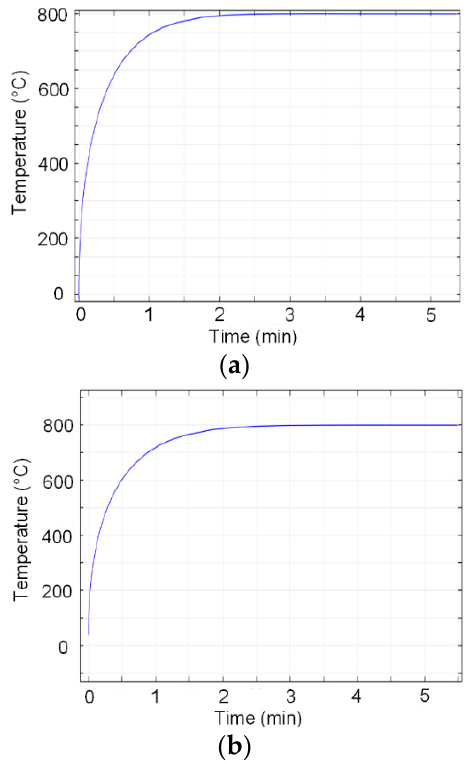
Figure 3. Temperature rising rate curve of mineral and vegetable oil samples: ( a ) Mineral oil; ( b ) Vegetable oil.